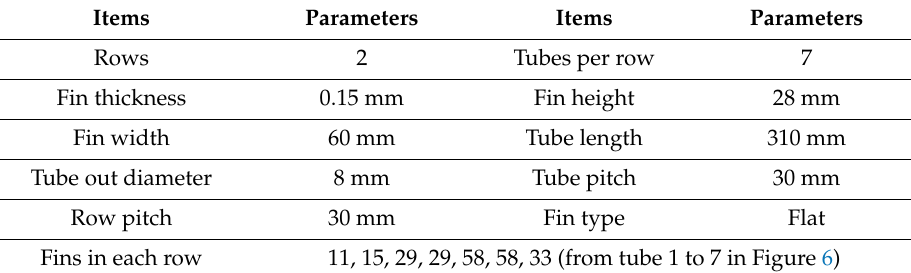
Figure 6. Schematic diagrams of the evaporator and the elements: ( a ) evaporator; ( b ) elements. Table 5. Parameters for the evaporator of the